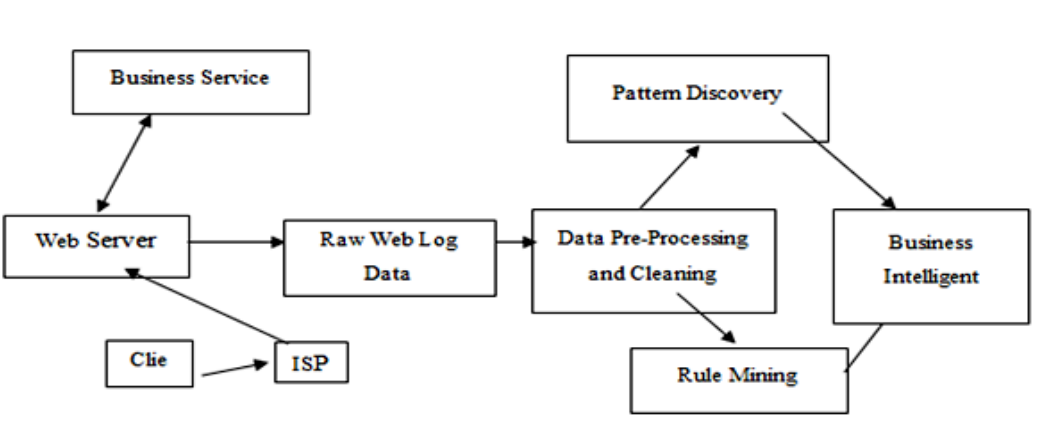
Figure 1. The proposed architecture of intelligent server